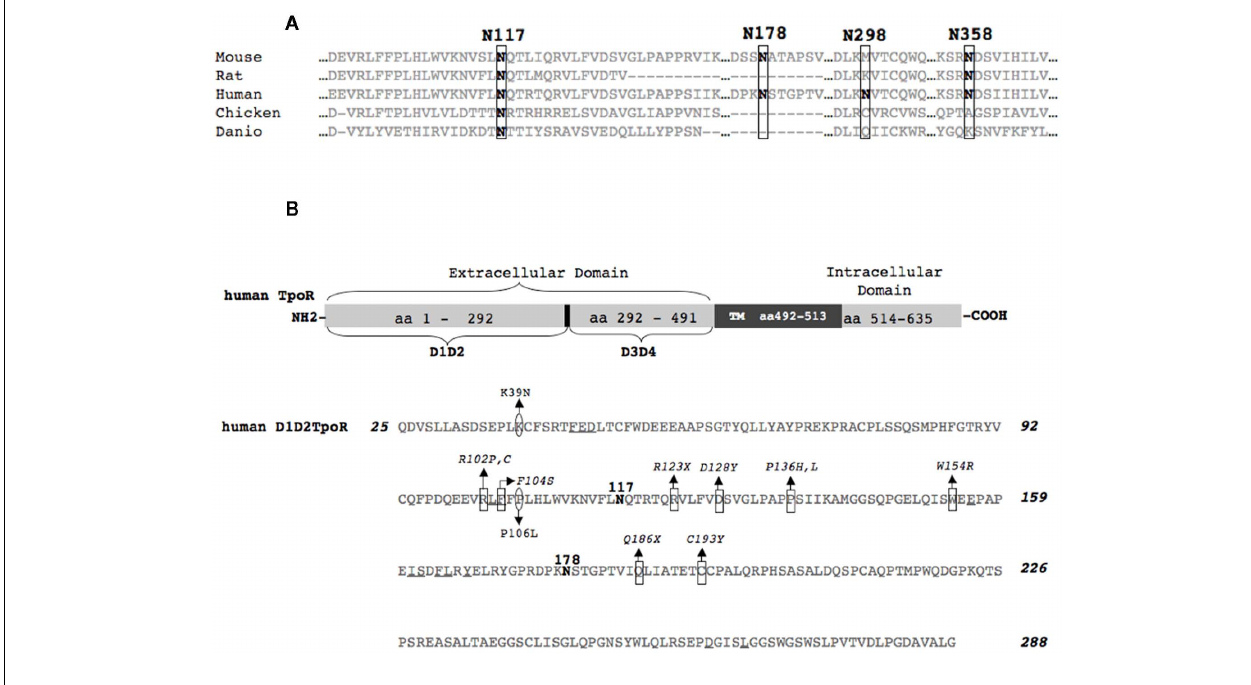
module.The important aminoacids forTpo binding are underlined (Deane et al., 1997). In square ( (cid:2) ) are depicted the aminoacids that are mutated in congenital amegakaryocytic thrombocytopenia (Ballmaier et al., 2001; Germeshausen et al., 2006;Tijssen et al., 2008; Fox et al., 2009) and in round circles ( (cid:3) ) the aminoacids that are mutated in familial thrombocytosis (Moliterno et al., 2004; El-Harith El et al., 2009).TM, transmembrane region; aa, aminoacid; D1D2, sub-domains of the distal cytokine receptor module; D3D4, sub-domains of the proximal cytokine receptor module; NH2, N-terminus of the protein; COOH, C-terminus of the protein; X, any